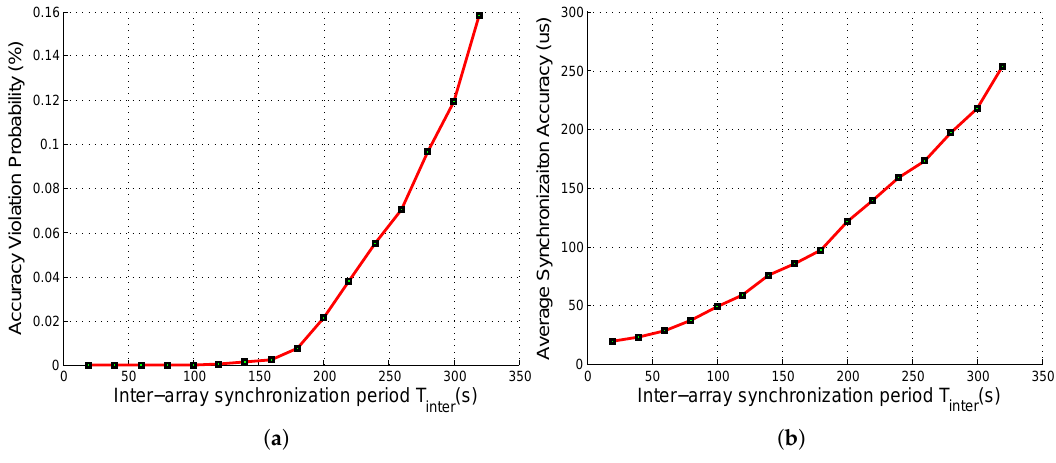
Figure 9. Inter-array synchronization metrics under different inter-array synchronization periods: ( a ) accuracy violation probability; ( b ) average synchronization